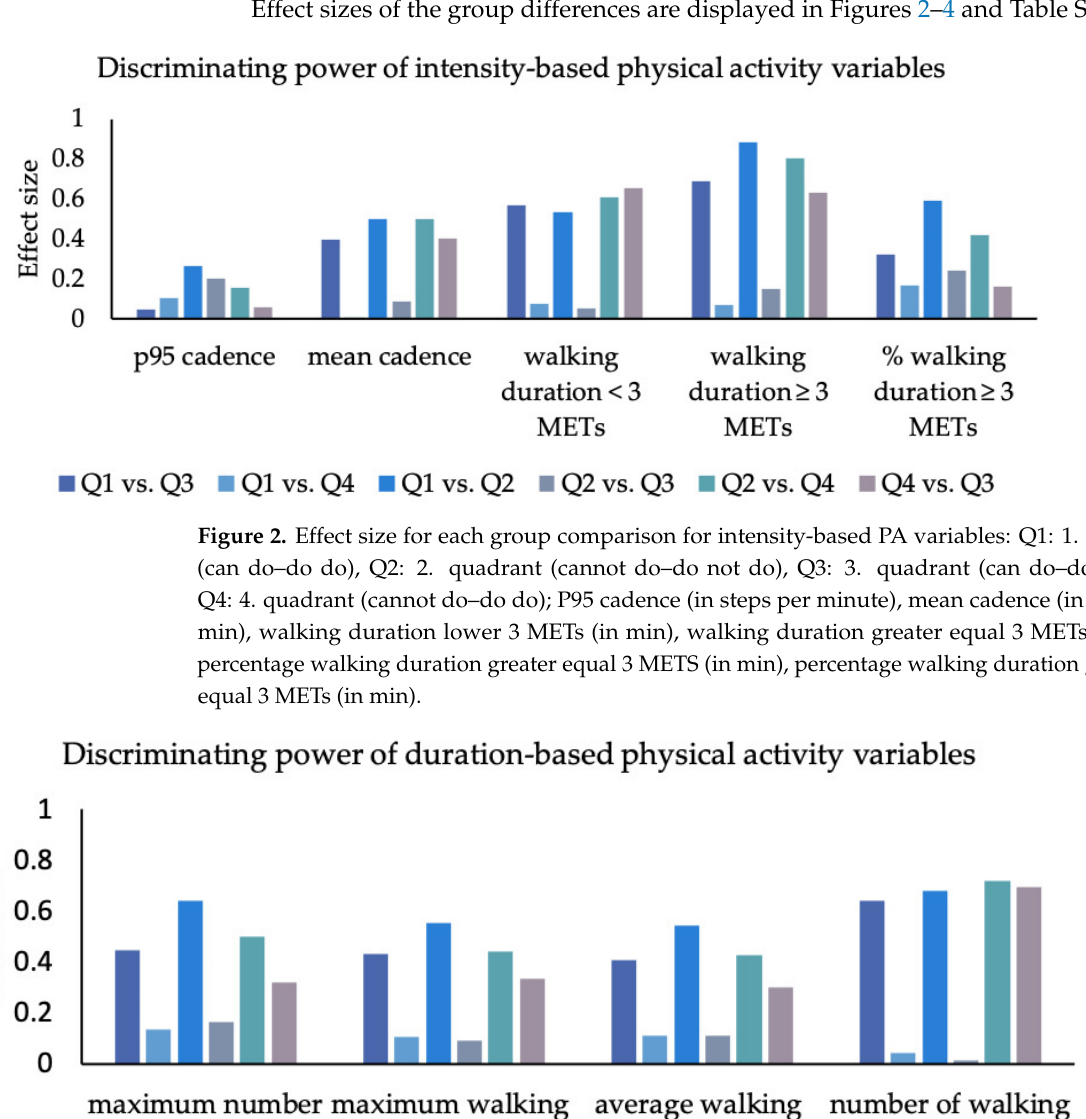
Figure 4. The effect size for each group comparison for frequency-based PA variables. Q1: 1. quad- rant (can do–do do), Q2: 2. quadrant (cannot do–do not do), Q3: 3. quadrant (can do–do not do), Q4: 4. quadrant (cannot do–do do); percentage (%) number of walking intervals < 10 s, percentage (%) number of walking intervals length < 20 s, percentage number of walking intervals length < 60 s. 3.3. Walking Intensity The “p95 cadence” differed between all groups with a low effect size of 0.04 to 0.27 (mean = 0.14; SD = 0.09). In contrast, the effect sizes of the mean cadence ranged from <0.01 to 0.50 (mean = 0.32; SD = 0.22). In both variables, the smallest difference was found be- tween the “can do–do do” and the “can do–do not do” quadrants. The largest differences were found between the “can do–do do” and the “cannot do–do not do” groups. With respect to the “walking duration lower 3 METs”, the four quadrants differed with effect sizes of 0.05 to 0.66 (mean = 0.42; SD = 0.28). The smallest differences were found between the “can do–do not do” and the “cannot do–do not do” quadrants. The